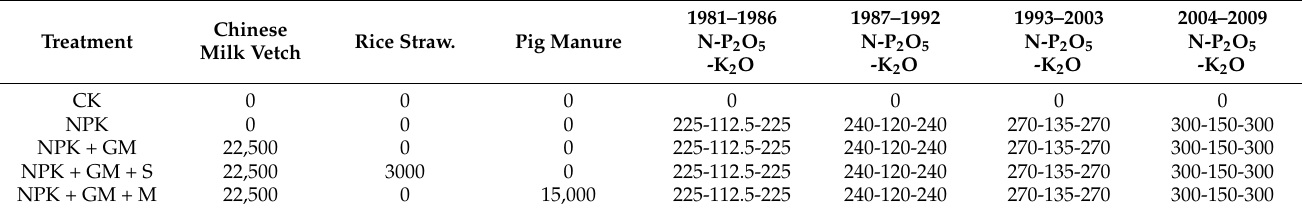
Table 2. Amount of fertilizer applied yearly (kg · ha − 1 ).